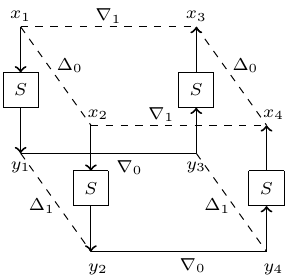
Figure 3: Generation of a right quartet at the S-box